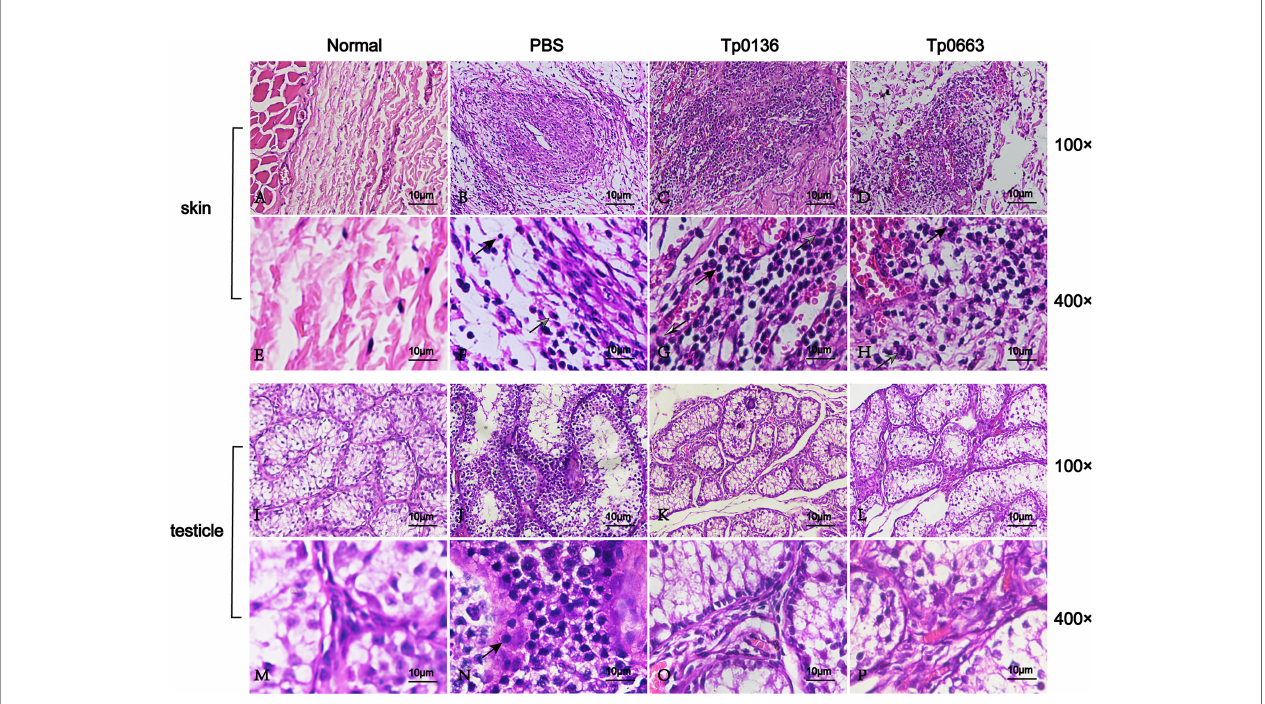
FIGURE 5 | Histopathological changes of skin and testicle tissue after T. pallidum infection in rabbits. Skin and testicle tissues from normal tissue control (A, E, I, M) , PBS- (B, F, J, N) , Tp0136- (C, G, K, O) , or Tp0663-immunized rabbits ( D, H, L, P , respectively) were sectioned and stained with H&E 21 days after infection with T. pallidum . Rabbits immunized with PBS and uninfected rabbits were used as controls. In fl ammatory in fi ltrates in the skin and testicle tissue of rabbits were localized and predominantly lymphohistiocytic (black arrow = lymphocyte; black and white arrow = macrophage; gray arrow =